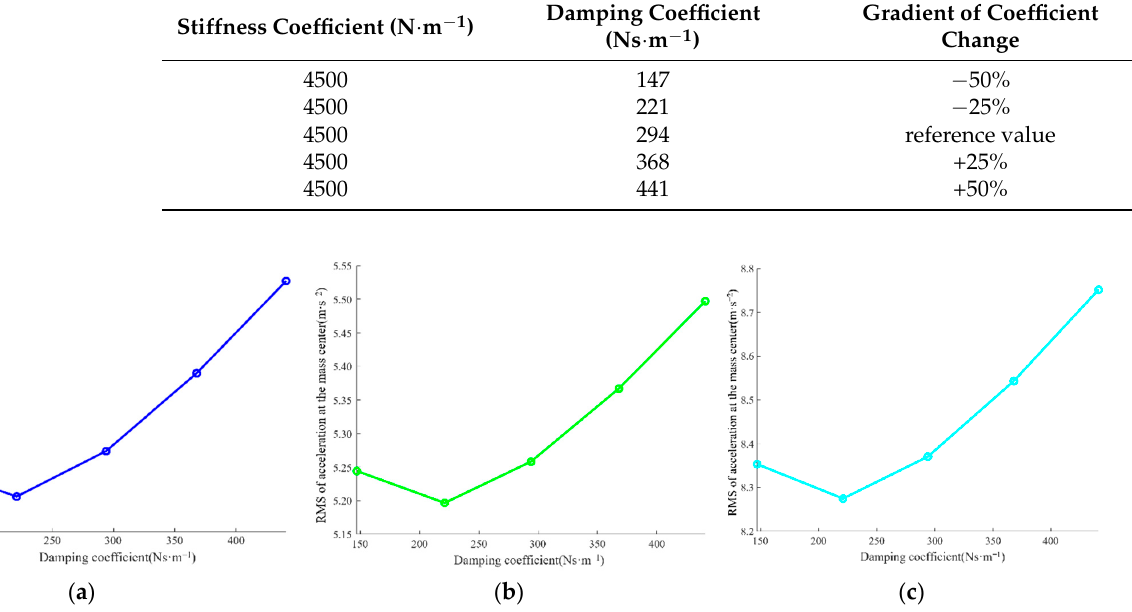
Figure 12. Damping change simulation comparison with large heave motion. ( a ) The amplitude of 0.1 m; ( b ) Amplitude of 0.25 m; ( c ) Amplitude of 0.4 m.